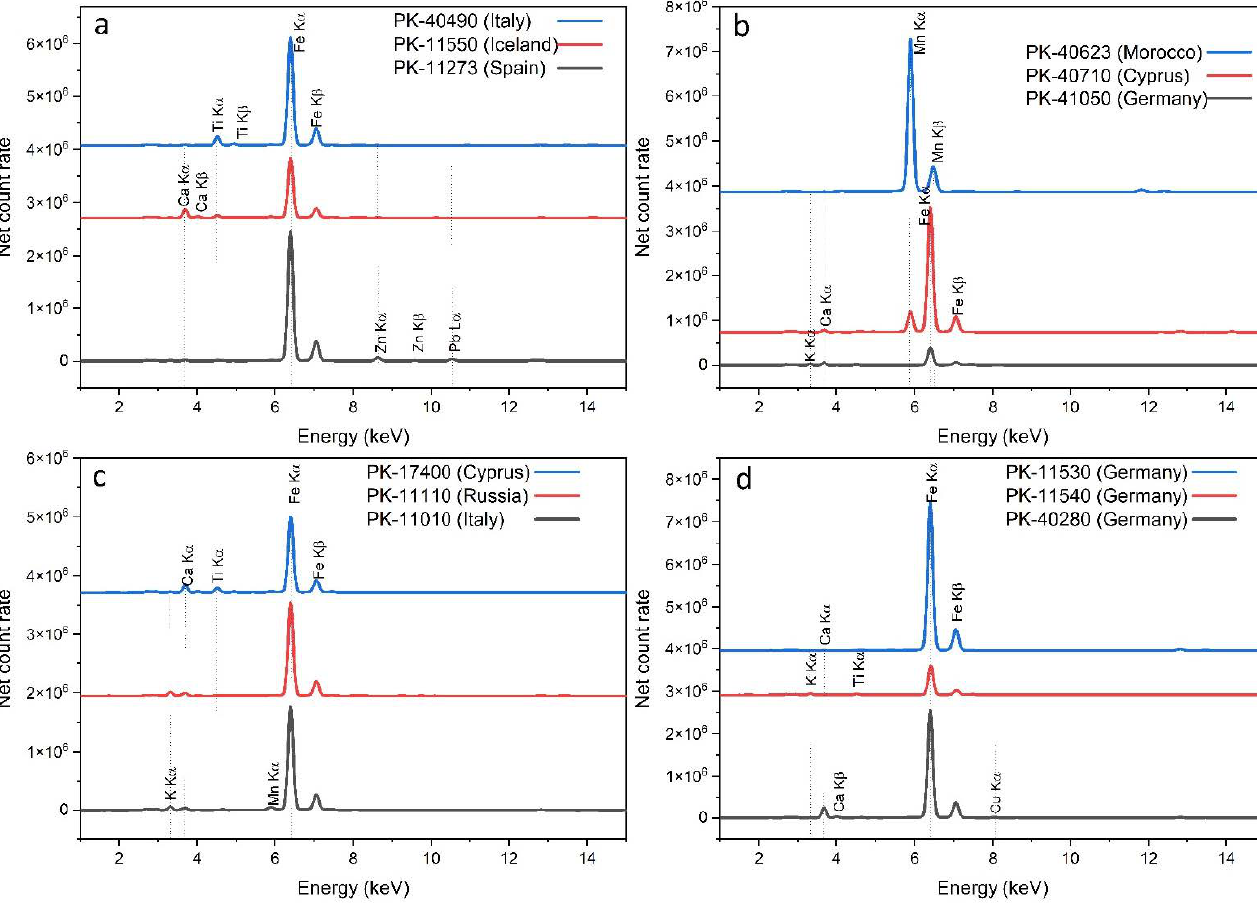
Figure 6. XRF spectra for some of the ( a ) red, ( b ) brown, ( c ) green and ( d ) yellow